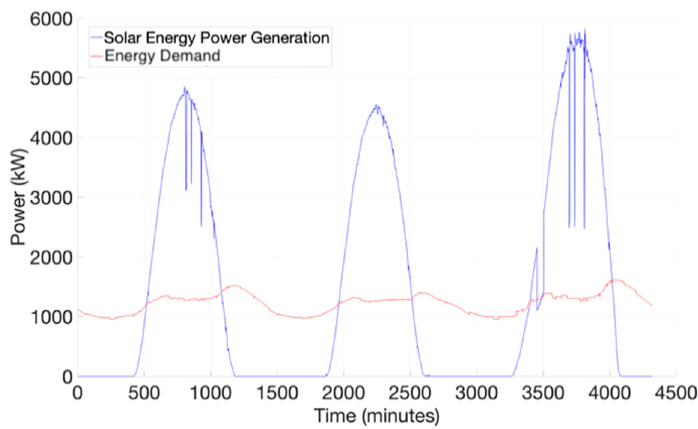
Figure 6. Electricity demand (low voltage).